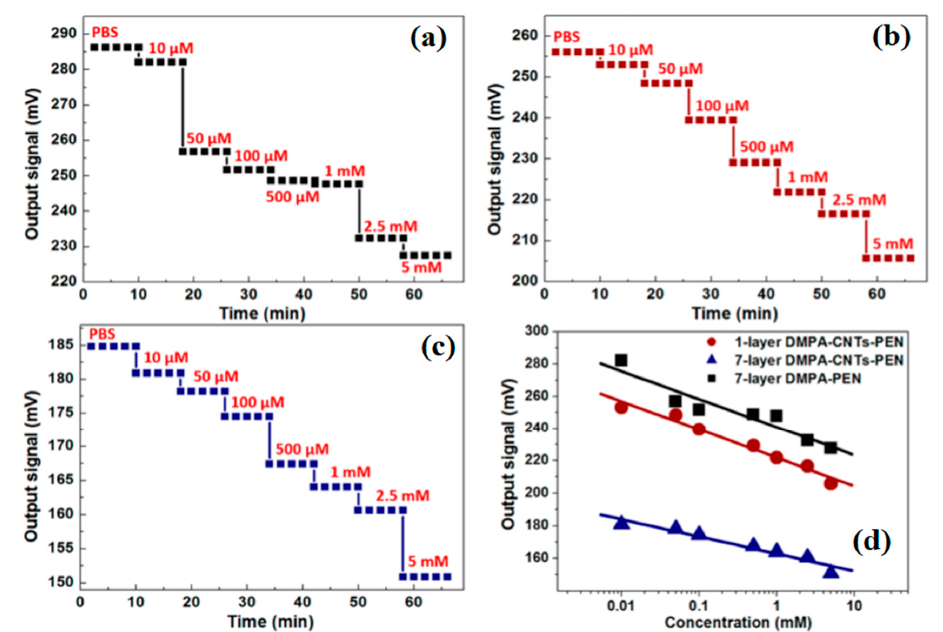
Figure 5. ConCap response curves toward penicillin G detection at different concentrations for LB film-incorporated EIS sensors: ( a ) seven-layer DMPA-penicillinase; ( b ) one-layer DMPA-CNTs-PEN; and ( c ) seven-layer DMPA-CNTs-PEN. ( d ) Calibration curve of ConCap responses for the LB films correlated with penicillin concentrations [93].